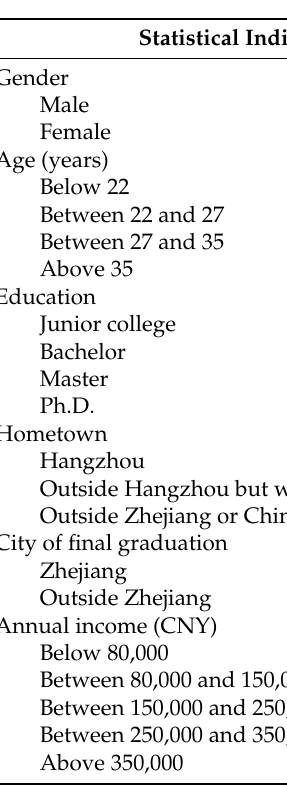
Table 1. Sample of the